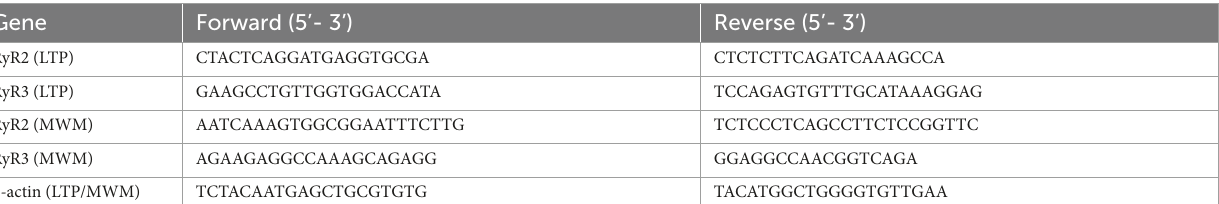
TABLE 1 Primer sequences